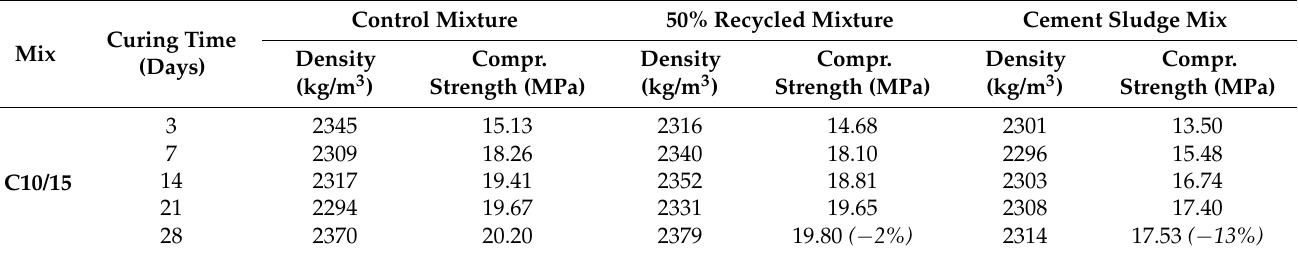
Table 8. Compressive strength results at different curing